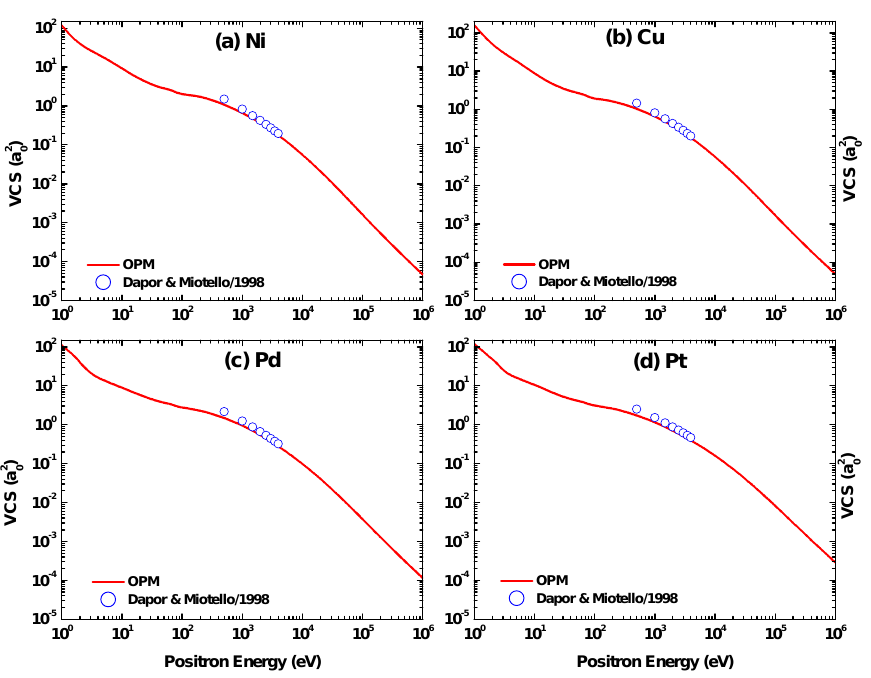
Figure 38. The present OPM calculations of the VCS for positron impact scattering from ( a ) Ni 58 , ( b ) Cu 63 , ( c ) Pd 108 , and ( d ) Pt 196 in comparison with the results from Dapor and Miotello [50].